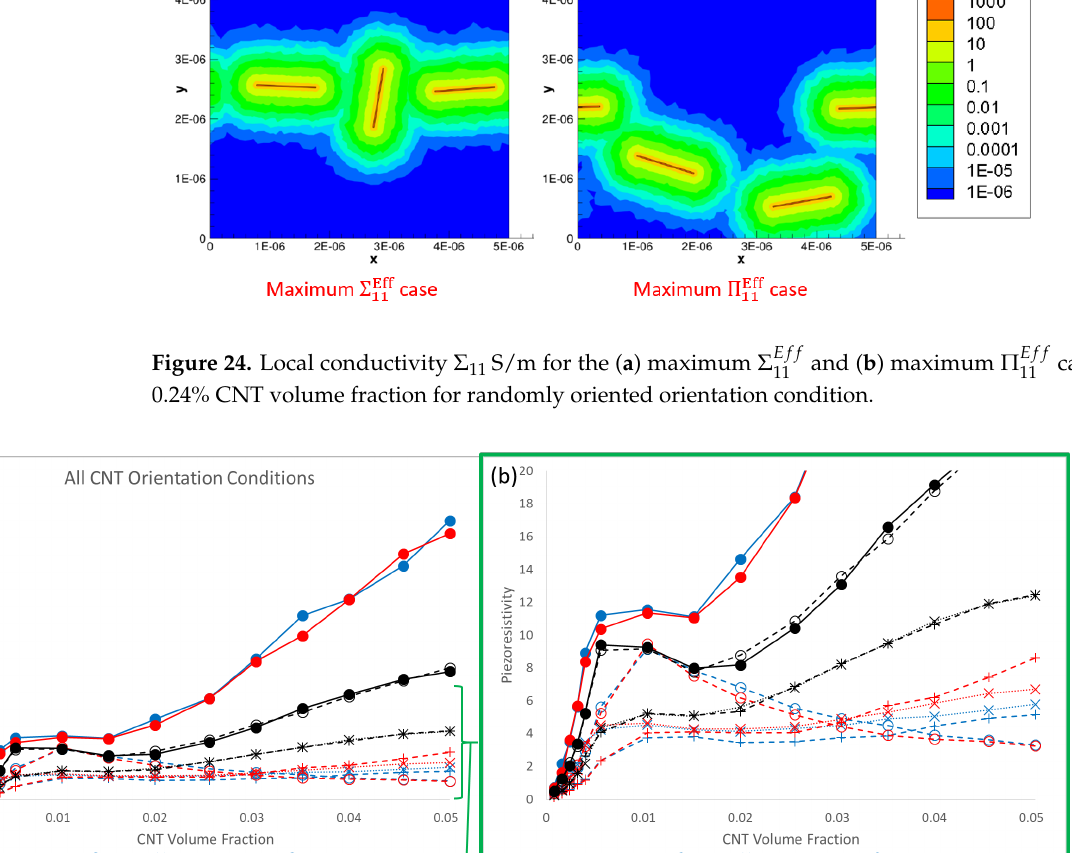
Figure 25. ( a ) Estimate of all non-zero piezoresistivity terms for all orientation conditions with ( b ) a zoomed in